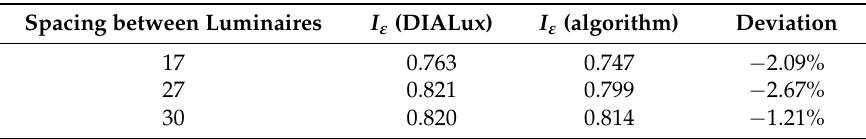
Table 3. Energy efficiency index obtained with DIALux and the algorithm.